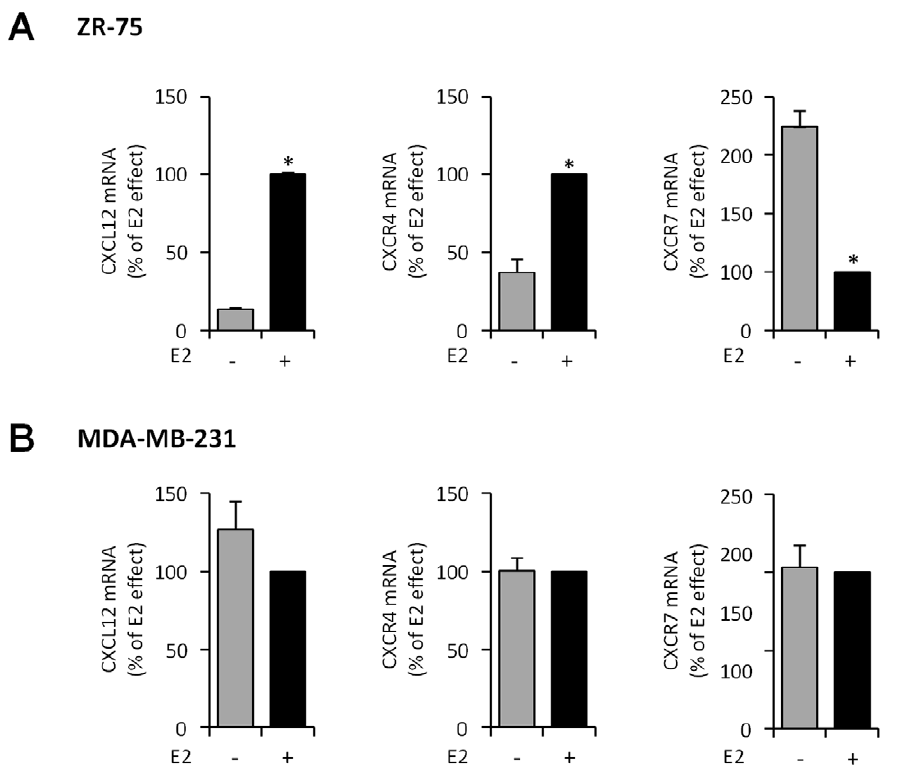
Figure 2. Regulation of CXCL12 , CXCR4 and CXCR7 mRNA expressions by E2 in ZR-75 and MDA-MB-231 cells. CXCL12 , CXCR4 and CXCR7 mRNA were assessed by quantitative real time PCR after 48 h treatment of ZR-75 (A) or MDA-MB-231 (B) cells to EtOH ( 2 ) or to10 2 8 M E2 ( + ). Transcript levels were normalized against GAPDH mRNA and data were calculated as percentage of the E2 effect. Data are from triplicate samples and are representative of three separate experiments. Asterisk indicates significant differences ( p , 0.05) between the control and ligand treated cells.